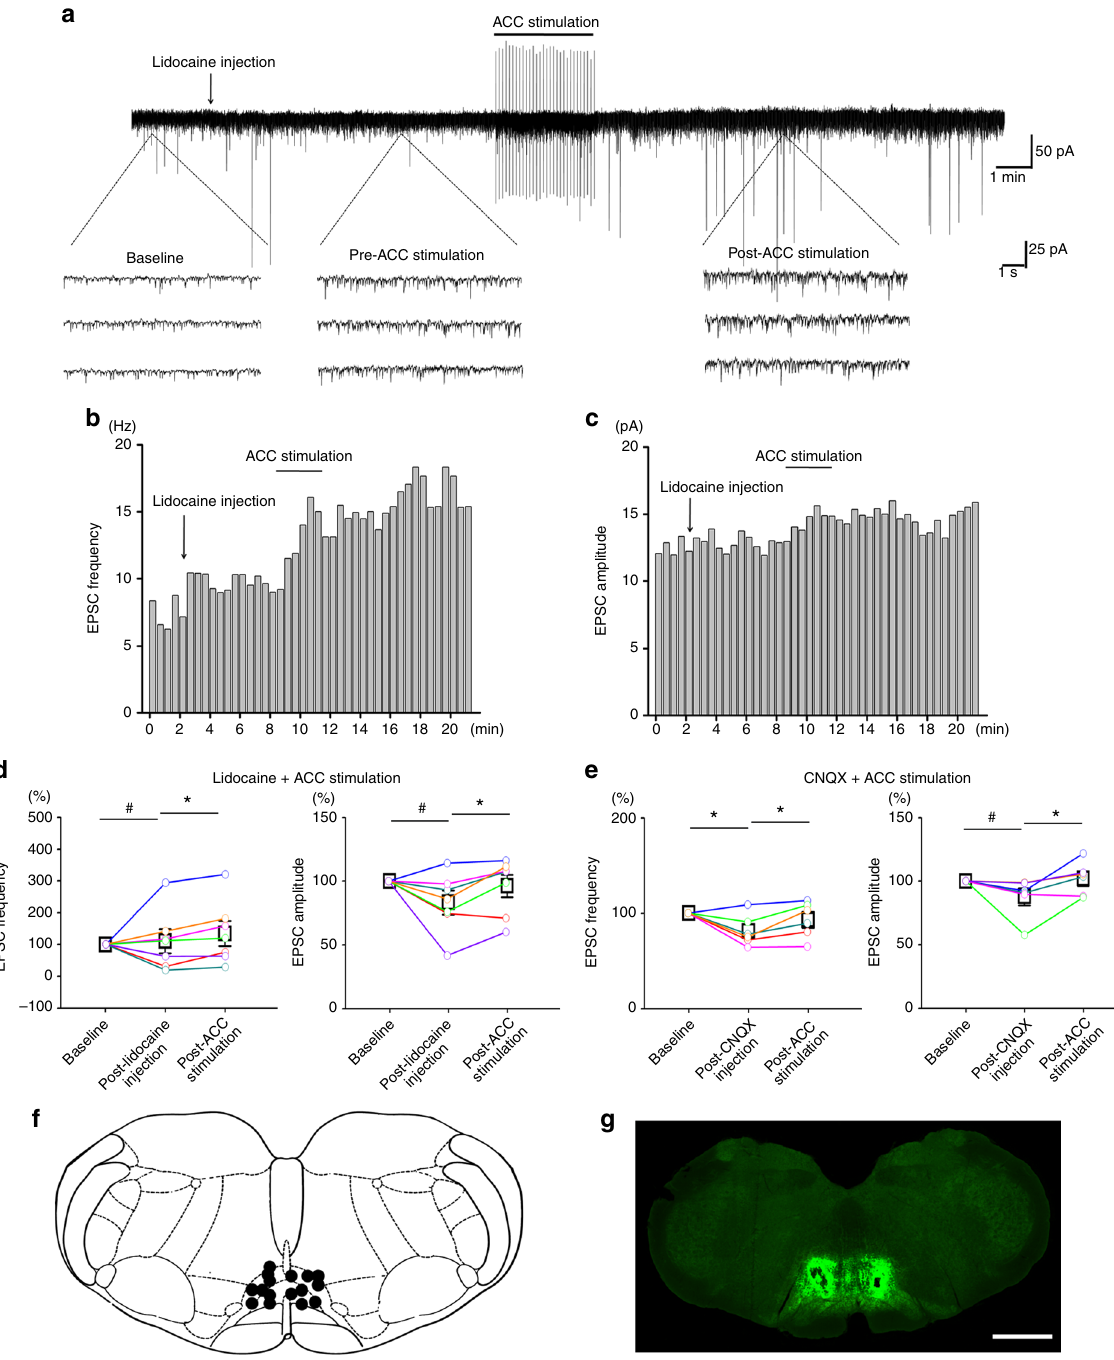
Fig. 3 RVM blockade did not block ACC stimulation-induced potentiation of the spinal sEPSC in sham operated rats. a – c One sample ( a ) and the histogram fi gures showing the frequency ( b ) and amplitude ( c ) of the spinal sEPSC with lidocaine blockade of RVM were potentiated by following ACC stimulation.